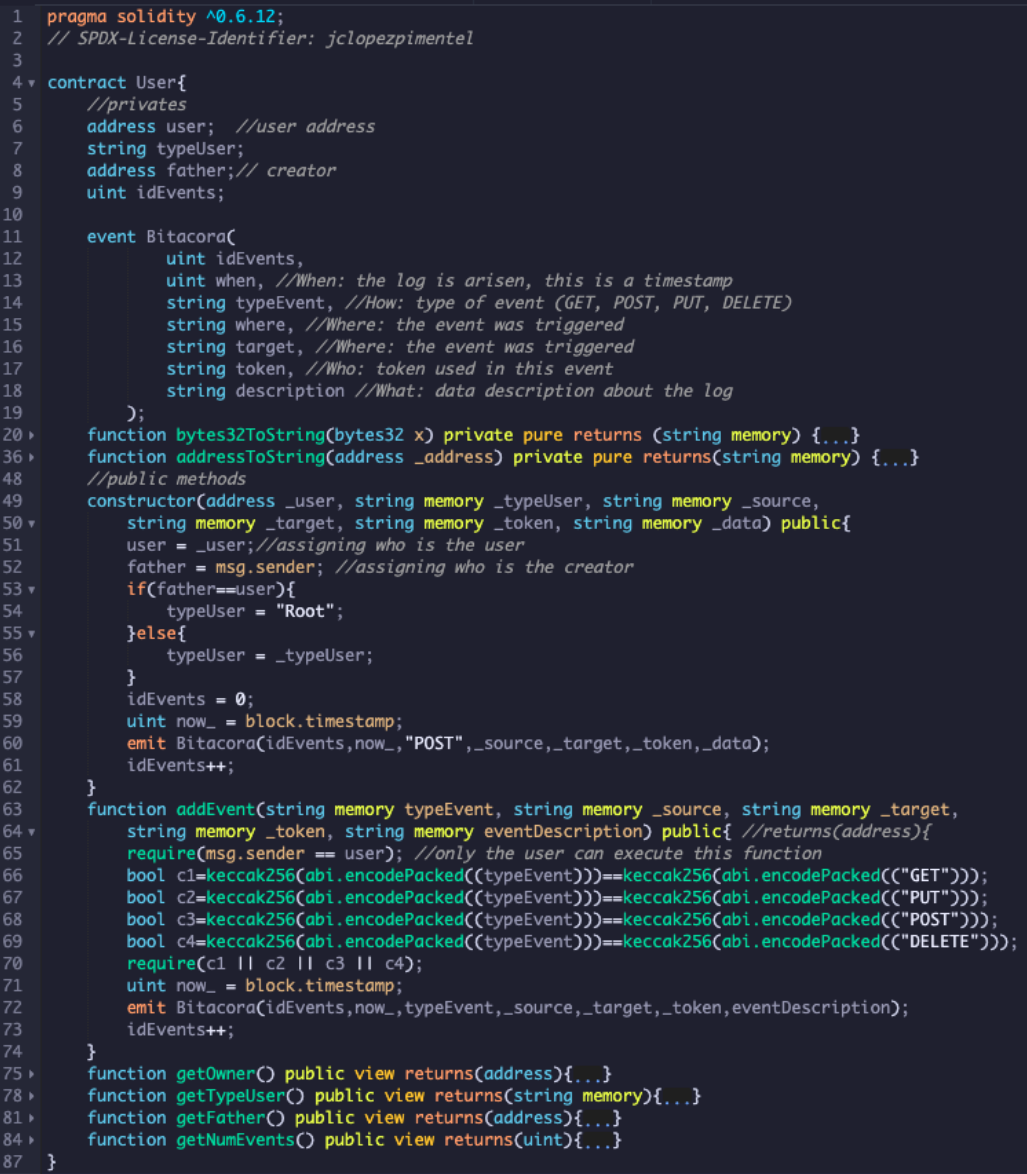
Figure 9. User smart contract in Solidity language